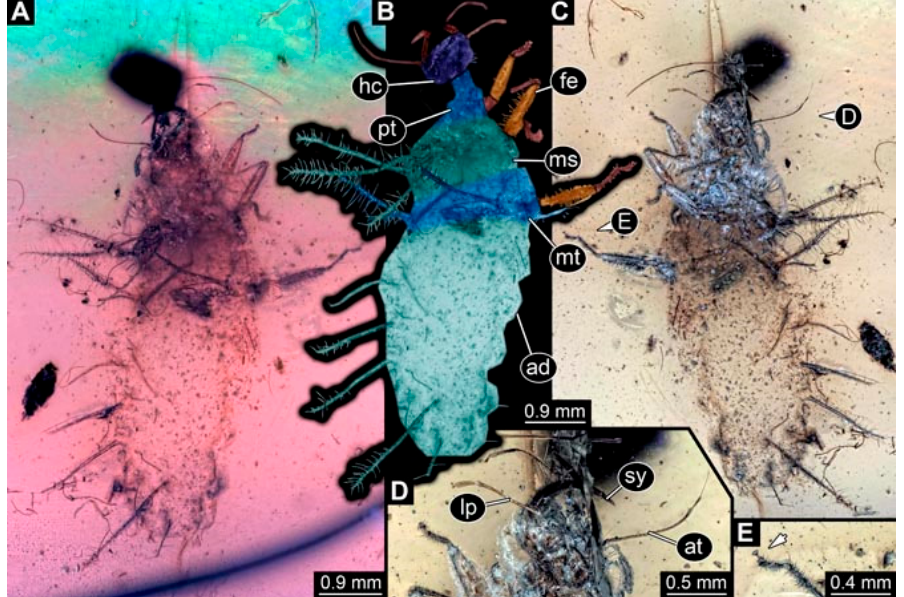
Figure 46. Specimen 4876 (Weiterschan BuB 11); Myanmar amber. ( A ) Dorsal view. ( B ) Dorsal view, colour-marked. ( C ) Ventral view. ( D ) Close-up of head capsule in ventral view. ( E ) Close-up of trunk appendage with empodium (arrow). Abbreviations: ad = abdomen; at = antenna; fe = femur; hc = head capsule; lp = labial palp; ms = mesothorax; mt = metathorax; pt = prothorax; sy = stylet.